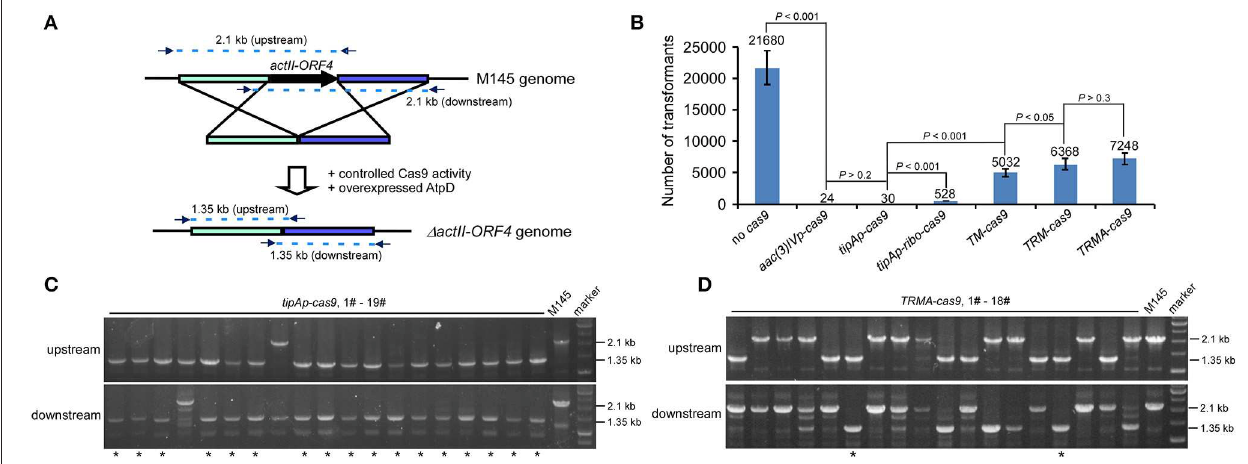
FIGURE 2 | actII-ORF4 editing in S. coelicolor with fine-tuned controls of Cas9 and overexpression of atpD on the pIJ101 ori plasmid under non-induction conditions. (A) Diagram of actII-ORF4 deletion in S. coelicolor based on engineered controls of Cas9. The primers for diagnostic PCR were shown as arrows, and the predicted sizes of PCR fragments in wild type (M145) and the 1 actII-ORF4 mutant were also shown. The two 2.1kb fragments are the predicted upstream and downstream PCR products at actII-ORF4 locus of wild type, while the two 1.35kb fragments are the corresponding PCR products after actII-ORF4 is deleted in the mutant. Desired genome editing is verified by simultaneous genotype investigation of the upstream and downstream regions by PCR. (B) Transformation efficiency during actII-ORF4 deletion in S. coelicolor with various combinatory controls of Cas9 activities based on the pIJ101 ori plasmid. The estimated transformants were shown as mean ± SD (standard deviation) from three independent transformations, and the average transformant numbers were shown on the corresponding columns. ribo , theophylline-inducible riboswitch; TM , both Cas9 N713-pMag and nMagHigh1-Cas9 C714 split fusions expressed under tipAp ; TRM , both Cas9 N713-pMag and nMagHigh1-Cas9 C714 splits expressed under tipAp and riboswitch; TRMA , overexpressed atpD along with TRM . Statistical significance ( P < 0.001 or P < 0.05) was determined by two-tailed unpaired Student’s test. (C,D) Diagnostic PCR for CRISPR/Cas9-based actII-ORF4 deletion with Cas9 expressed from tipAp (C) or with engineered control of Cas9 (D) as shown in Figure 1A . The successfully edited mutants were indicated with